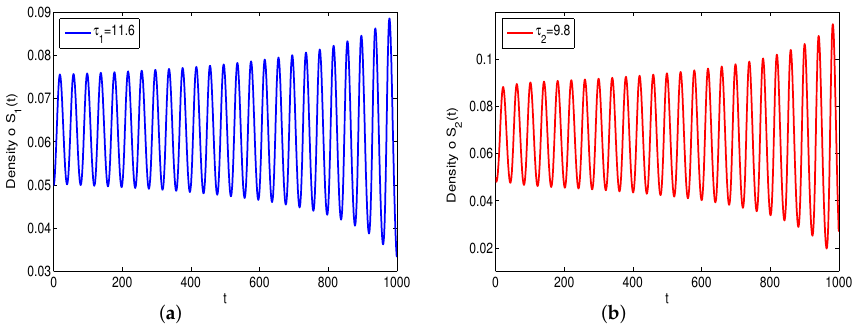
Figure 17. ( a ) The trajectory of S 1 ( t ) with τ 1 = 11.6. ( b ) The trajectory of S 2 ( t ) with τ 2 = 9.8.